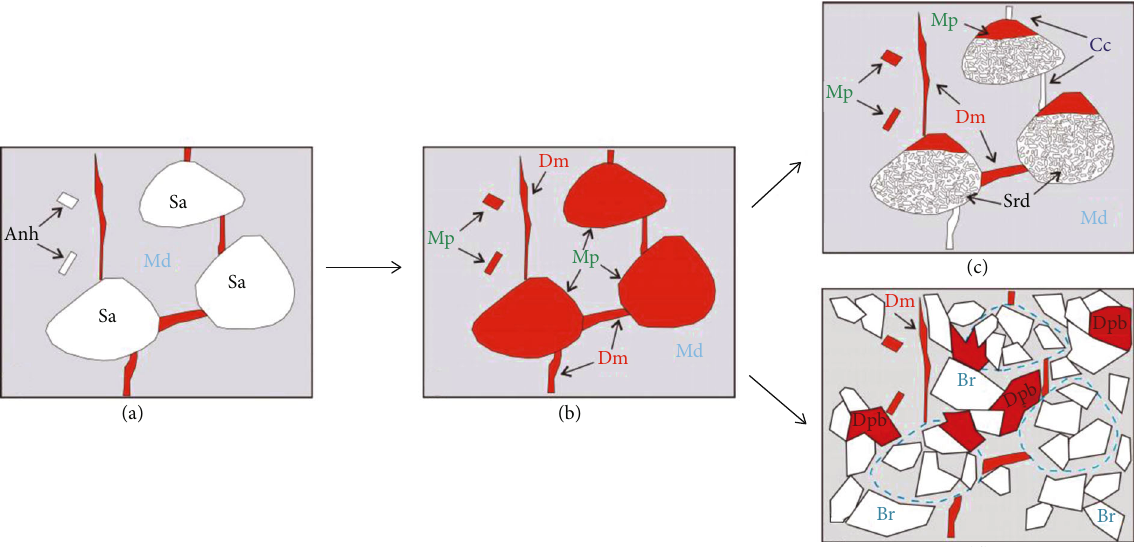
Figure 8: Schematic diagram of formation mechanism of dissolution pore-type dolostone reservoir (Anh = anhydrite; Sa = halite; Md = dolomicrite; Mp = moldic pore; Dm = dissolution microfracture; Srd = surrounding debris; Cc = calcite cement; Br = breccia structure; Dpb = dissolved pore between breccias). ((a) Powdery crystal dolostone containing gypsum and halite; (b) gypsum and halite moldic pores; (c) geopetal structure; (d) dissolution pores between